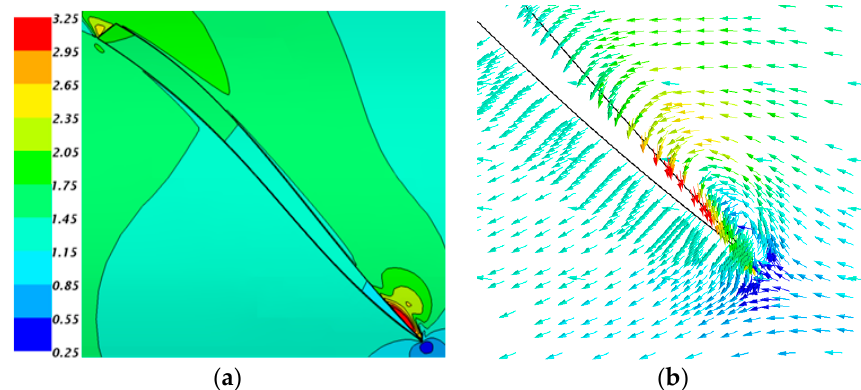
Figure 8. Non-dimensional velocity distribution cloud at 0.5 R section. ( a ) The non-dimensional velocity cloud; ( b ) The non-dimensional velocity vector cloud near the leading edge.